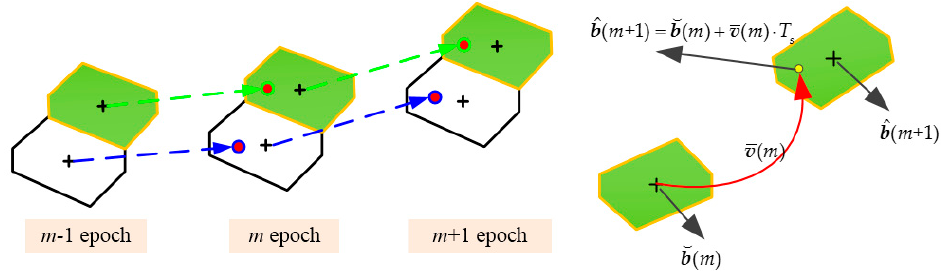
Figure 3. Illustration of the kinematic ME-MAFA in 2D.